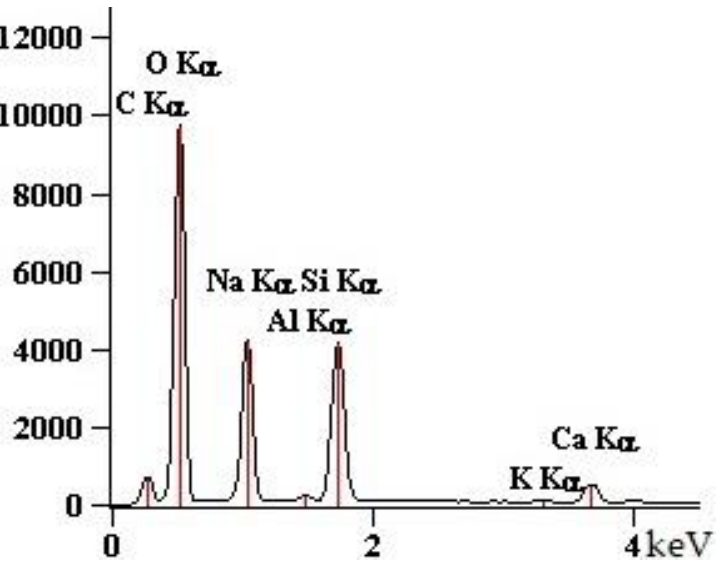
Figure 23. EDS spectrum of brick modified with 90% GS. Point 3.